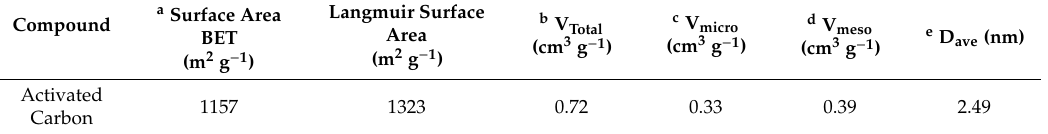
Table 6. Summary of the physical characteristics of the activated carbon.